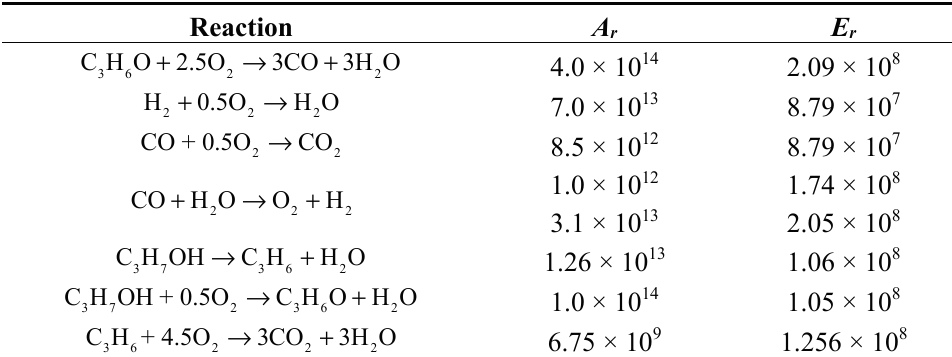
Table 2. Chemical kinetic parameters for (multi-step) gas-phase reaction of acetone and 2-propanol ( P = 1